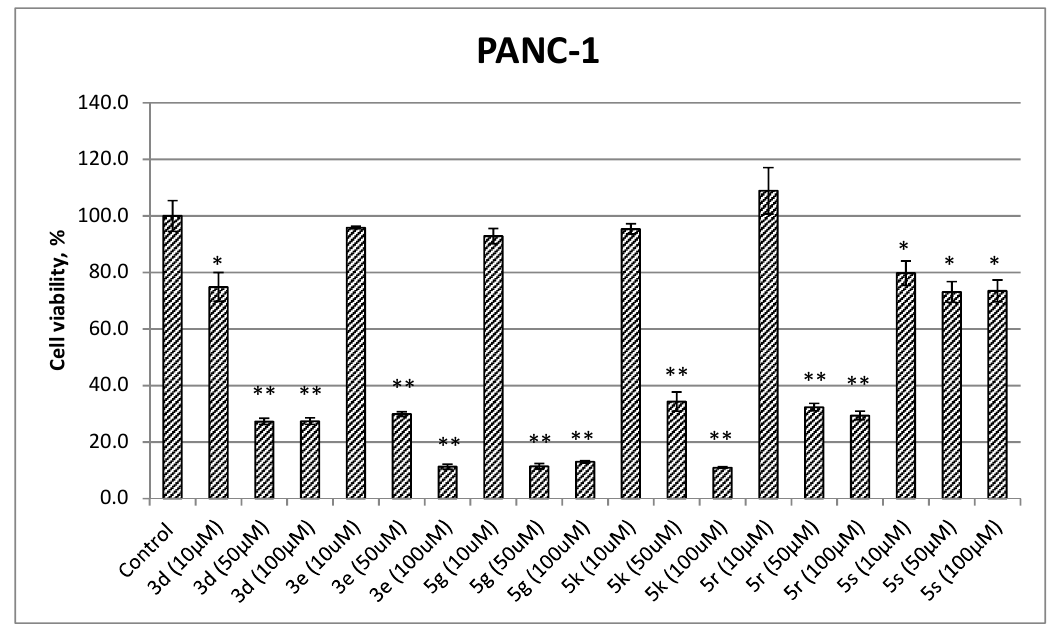
Figure 1. Cell viability MTT assay results for compounds 3d , 3e , 5g , 5k , 5r , and 5s at 10, 50, 100 µM concentrations against pancreas ductal adenocarcinoma (PANC-1) cell line (values are shown as the mean ± SEM of three experiments: (*) p < 0.05 and (**) p < 0.01 in comparison to control (0 µM)).